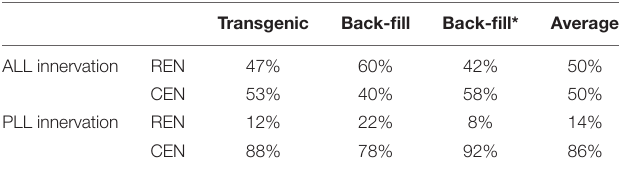
TABLE 2 | Distribution in the REN and CEN of analyzed inhibitory efferent cells innervating the anterior lateral line (ALL) or posterior lateral line (PLL). Transgenic Back-fill Back-fill*